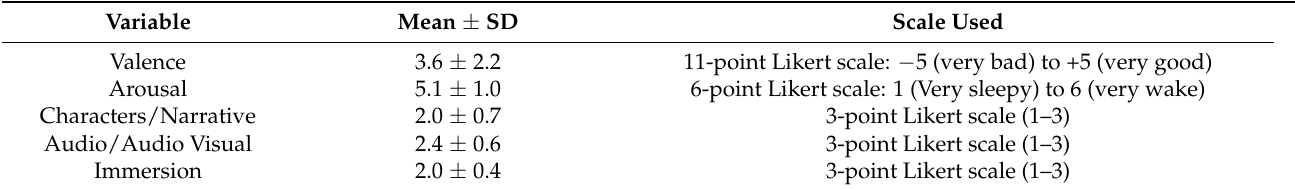
Table 2. Means and SD for Variables.